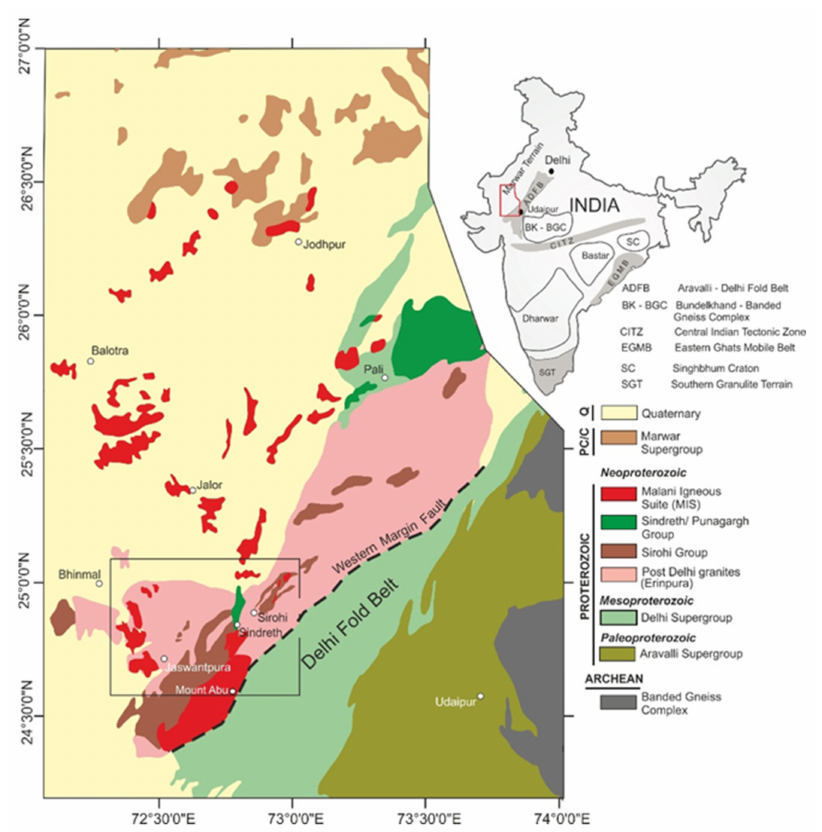
Figure 2. Location of the Malani samples from India. Measured samples are from within the frame. Geological map after [81]. Coordinates of the sample locations can be found in